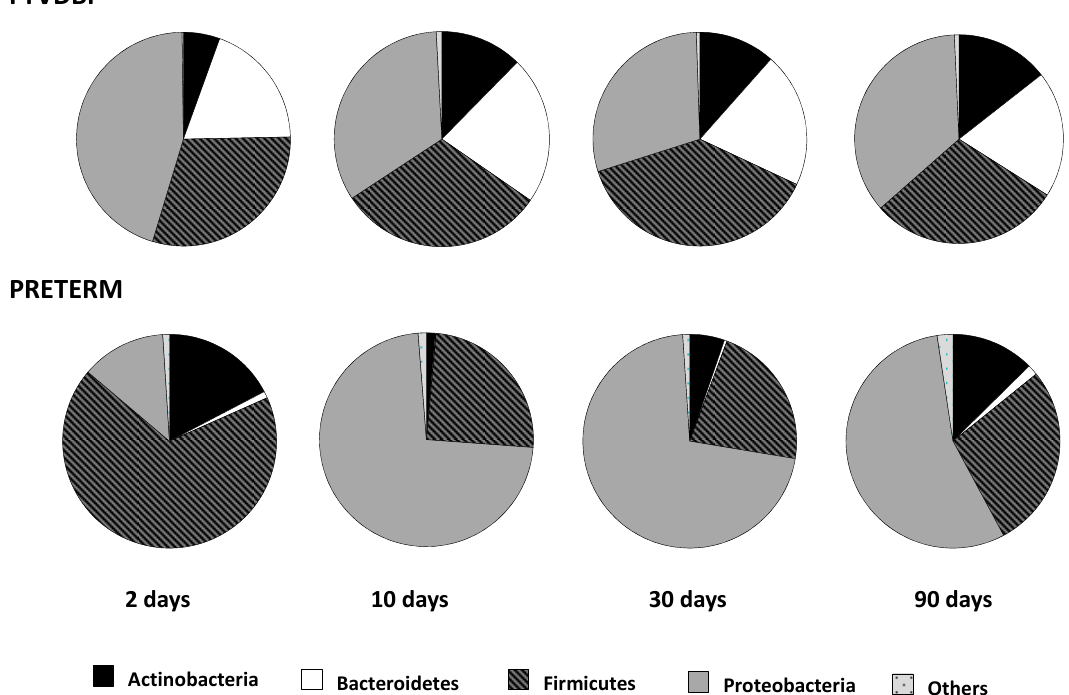
Figure 1. Aggregate microbiota (%) at phylum level in fecal samples from full-term, vaginally delivered, exclusively breast-fed (FTVDBF) vs. preterm infants at the different time points analyzed .